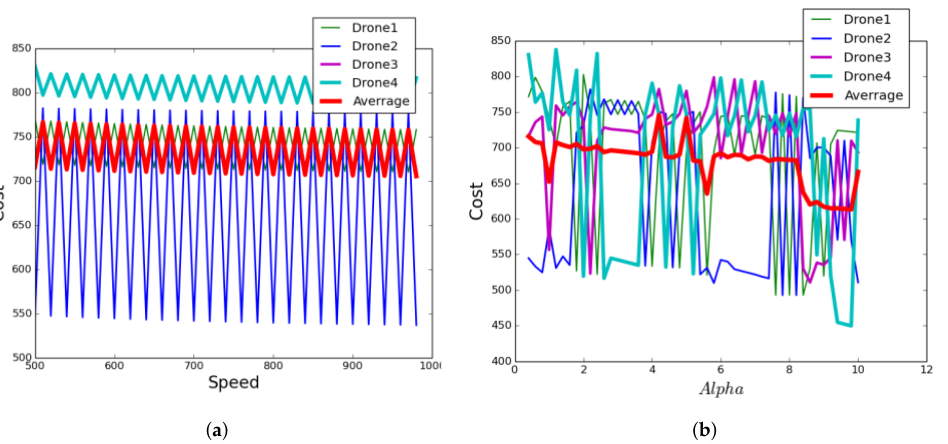
Figure 8. Impact of Speed and overdue time on the total cost ( a ) Variation of the cost with respect to the speed; ( b ) Variation of the cost with respect to the overdue time ( α